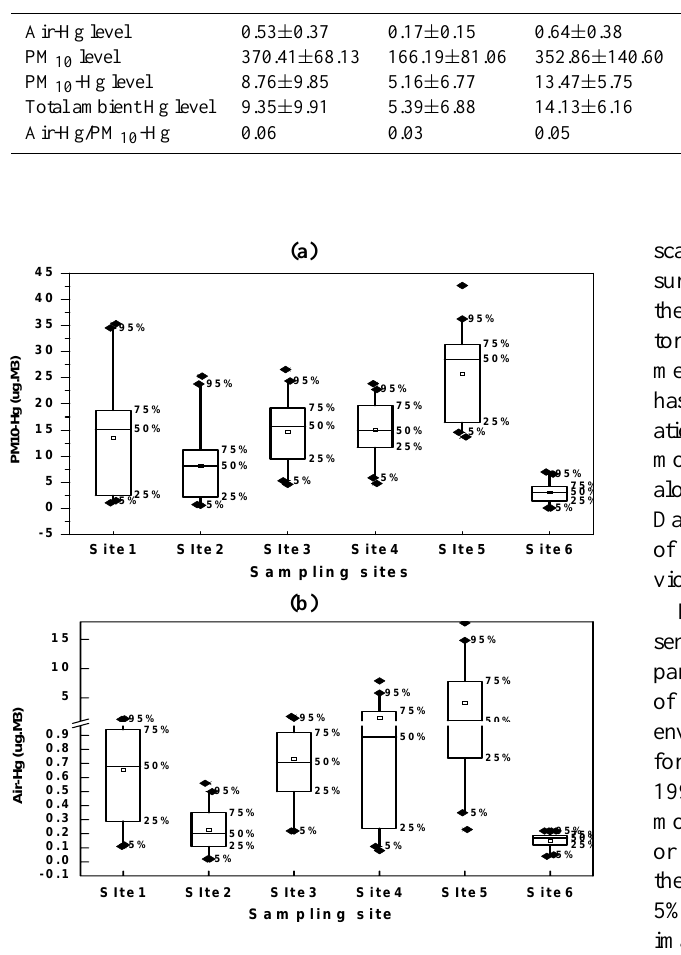
Fig. 3. Annual statistical box plots of ambient PM 10 (a) and Air- Hg levels measured at selected sites around an integrated steel plant Bhilai during March 2005–February 2006